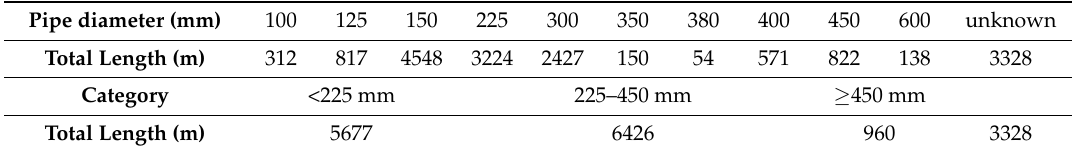
Table A1. Total length of pipes under 225 mm, 225 to 450 mm, and larger than 450 mm.